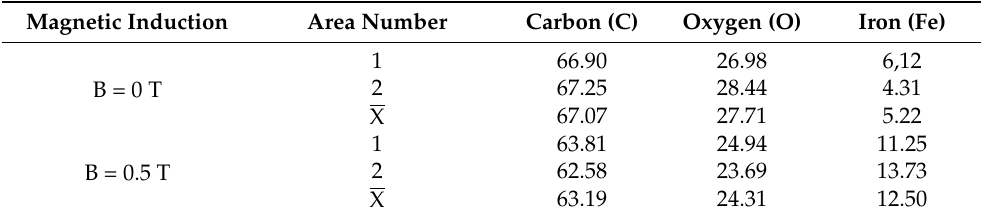
Table 2. Composition (in % b.w.) of the surface of (Ep 5) -based composites, formed in CMV (B = 0.5 T) and without a magnetic field (B = 0 T).